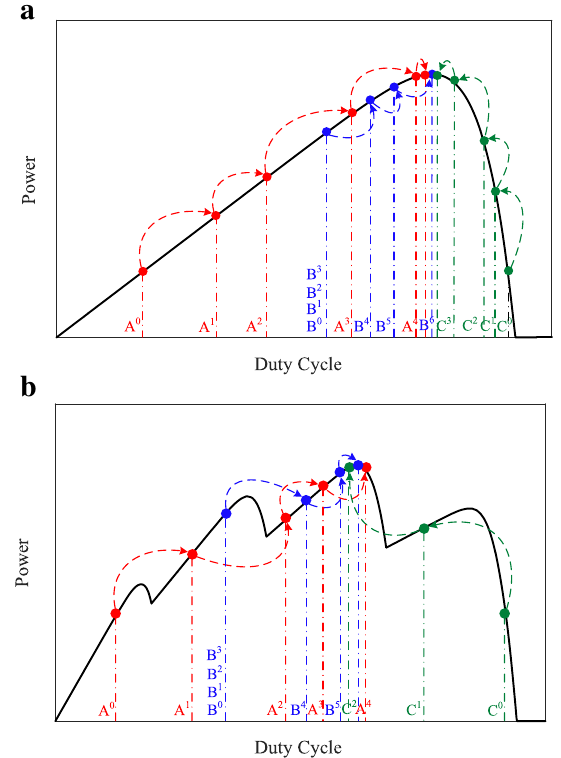
Fig. 3 The MPP searching path by FP algorithm. a Uniform irradiance. b Partially shaded